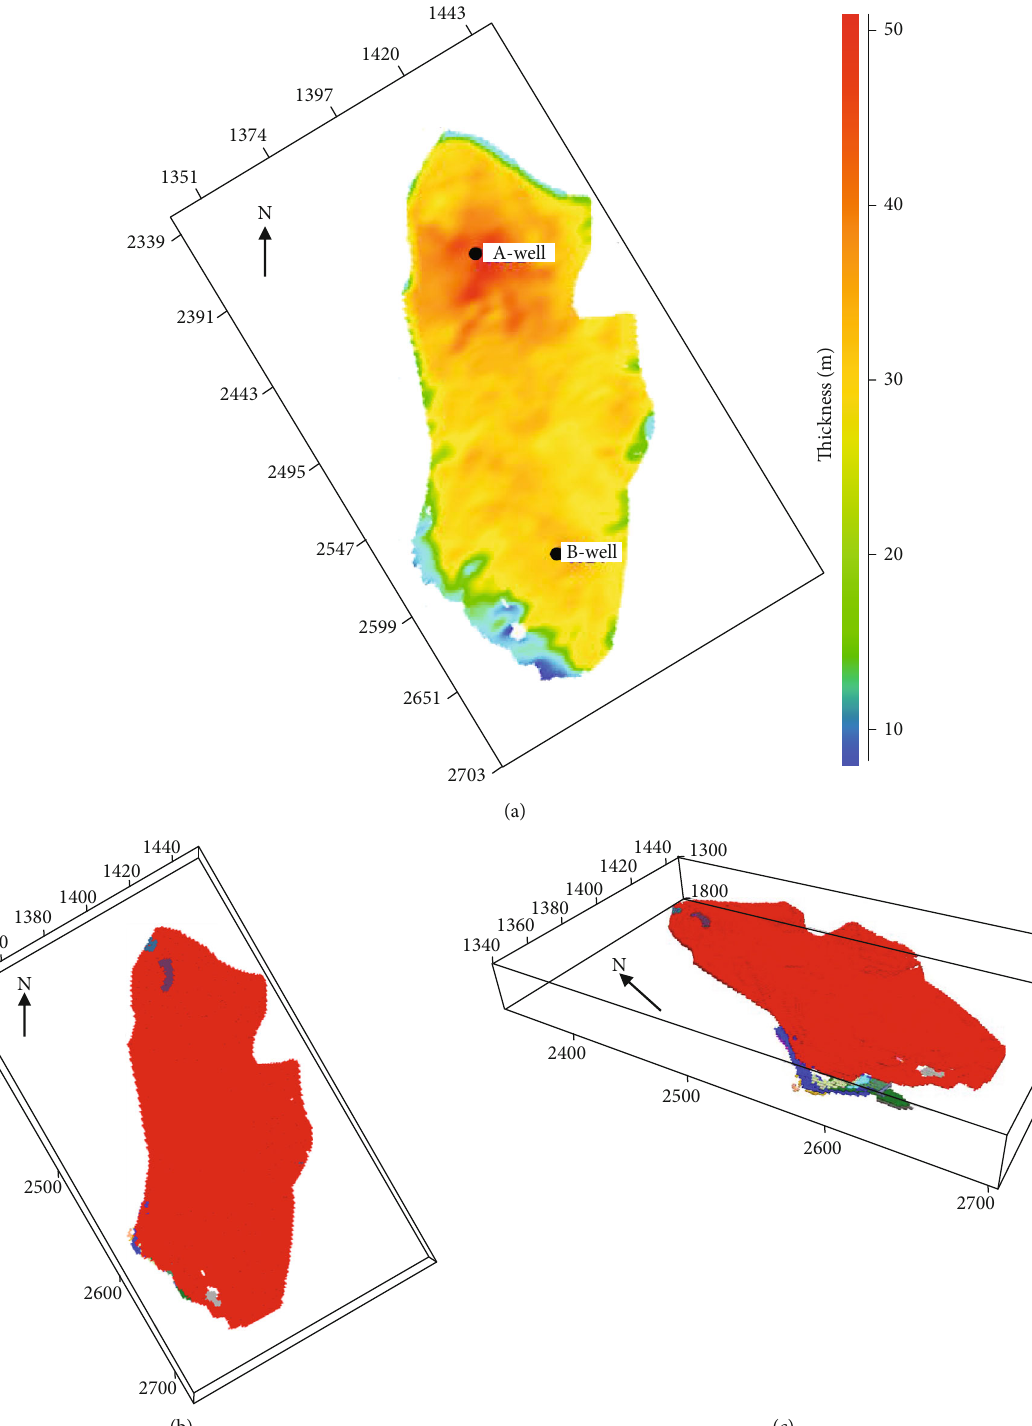
Figure 12: Thickness and spatial distribution of free gas in the A-B ore body: (a) thickness distribution; (b) top surface structure; (c) bottom surface